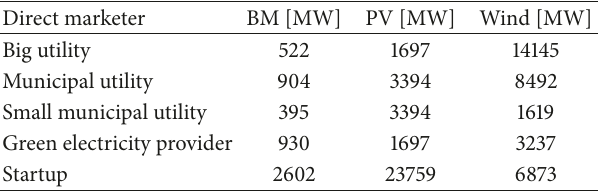
Table 6: Table representing the direct marketers’ initial portfolios. Direct